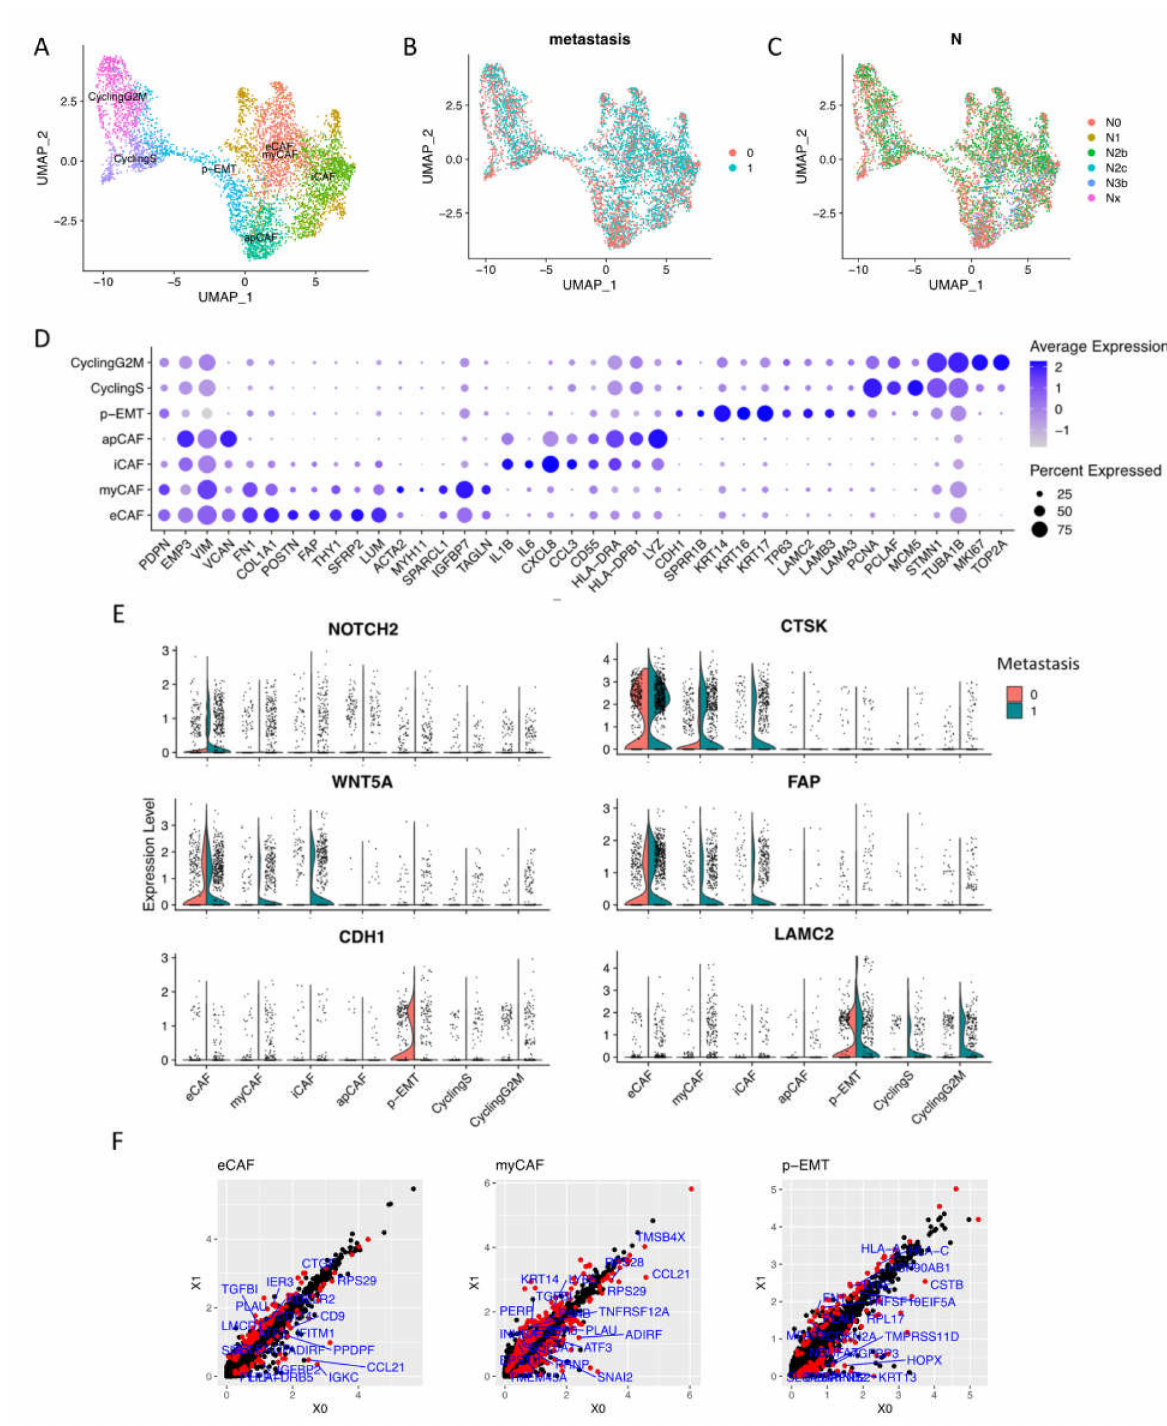
Figure 2. Sub-clusters of fibroblasts and epithelial cells. ( A ) Cells were sub-clustered into 7 sub-types and visualized by UMAP. ( B , C ) Integrated data included 2,270 non-lymph node metastasis cells (0, N0) and 3,239 lymph node metastasis cells (1, N1 to Nx). ( D ) Dotplot of average expression of the main markers of each sub-type in integration data. ( E ) Expressions of distinguished markers in non- (0) vs. metastasis (1) OSCC. ( F ) Differentiation of gene expression of eCAFs, myCAFs, and p-EMT tumor cells by pseudo bulk RNA-seq analysis in non- (X0) vs. metastasis (X1) conditions. Red dots are significantly different genes; black dots are total genes; blue labels are the top 20 significant different genes by adjusted p